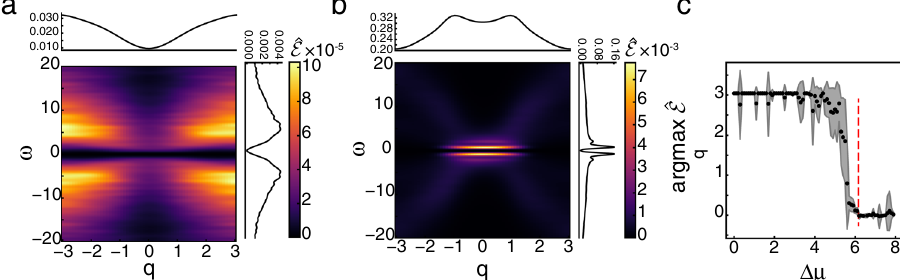
Fig. 5 Entropy production factor and macroscopic dynamics. a E averaged over N = 10 simulations for Δ μ = 4.0, i.e., Δ μ < Δ μ HB . Line plots on top and left of fi gure show marginals over ω and q , respectively. b Similar to a , but for Δ μ = 6.2, i.e., Δ μ > Δ μ HB . c Wavenumber, q , that maximizes ^ E as a function of Δ μ . Vertical dashed red line shows Δ μ HB . Black dots and shaded area show mean ± s.d. over N = 10